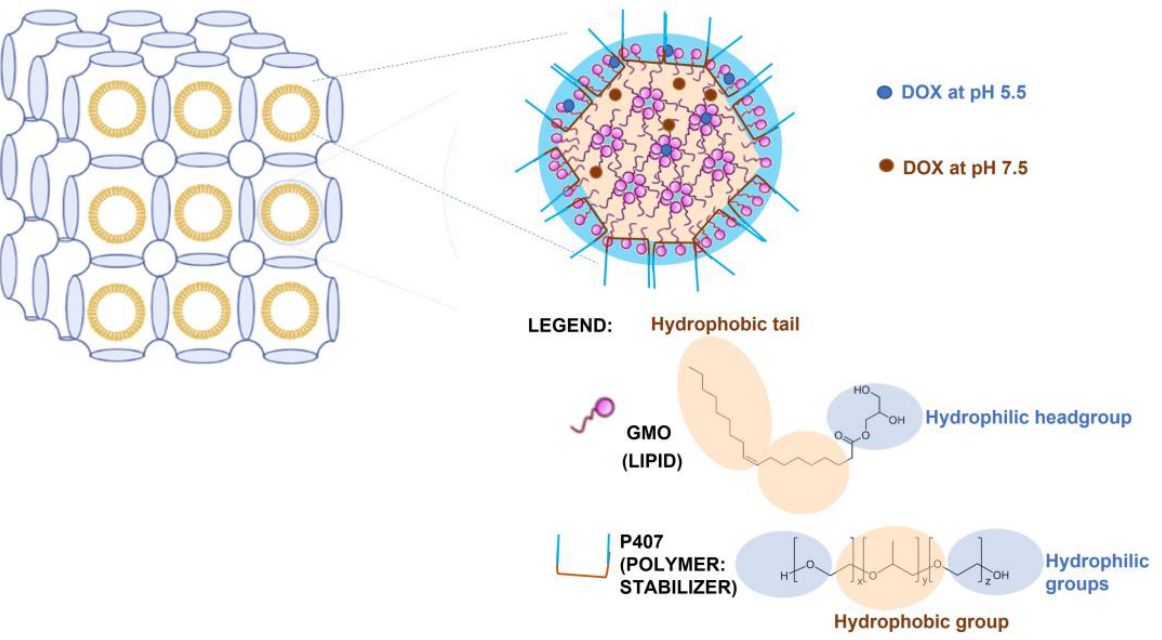
Figure 1. Schematic illustration of LNLCs loaded with DOX. LNLC continuous lipophilic bilayers are shown in yellow and hydrophilic channels in blue, with the amphiphilic block copolymer P407 stabilizer coating the nanoassembly. The drug release is pH-triggered since DOX is incorporated into the lipid matrix of the LNLCs at physiological pH (7.5), but it locates in water regions at acidic pH (5.5) characteristic of endosomal microenvironment.